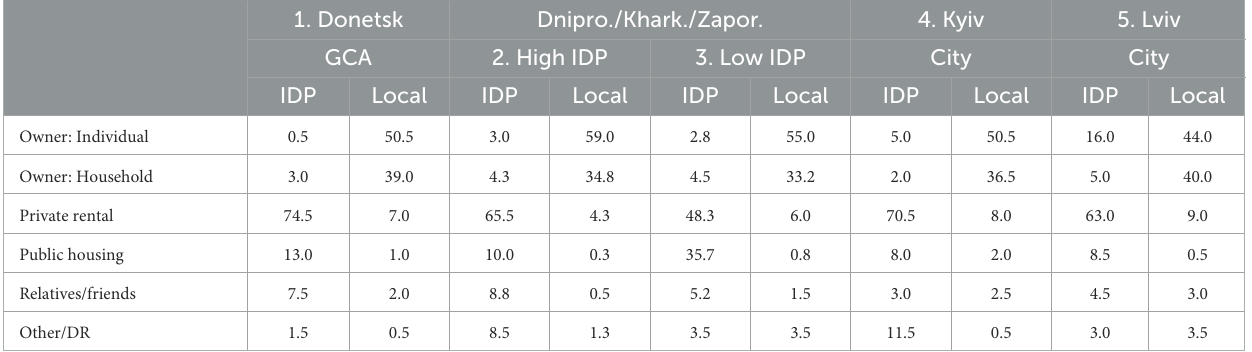
TABLE 3 Housing tenure by displacement zone (column